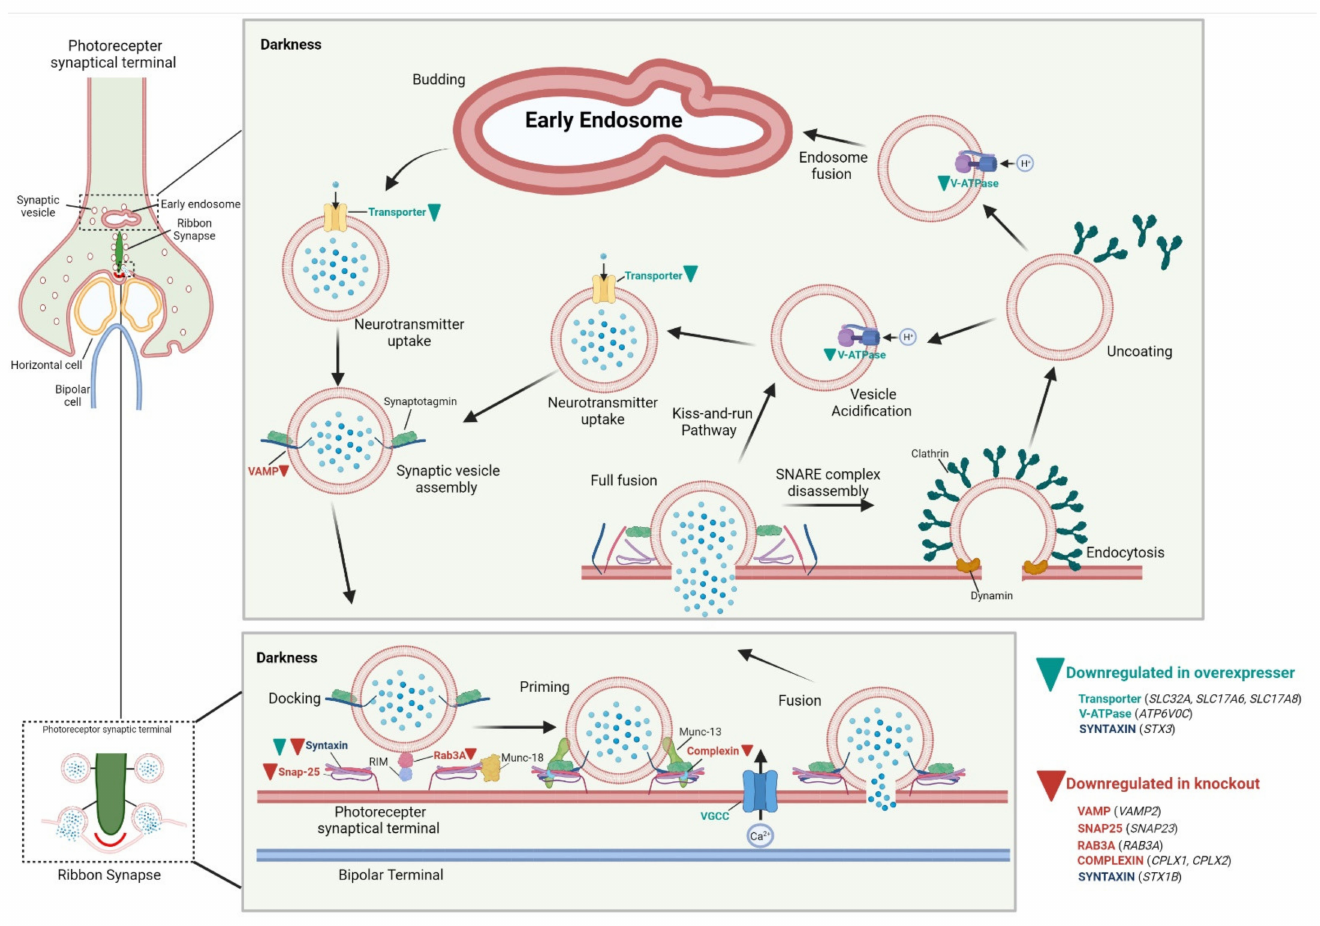
Figure 7. Downregulated genes of SOD3 mutants are associated with synaptic dysregulation. GO pathway analysis enriched for the Synaptic Vesicle Cycle pathway in both the downregulated gene lists of over-expresser and knockout animals. Genes downregulated the over-expresser are denoted in green along with a green arrowhead, while those downregulated in the knockout are in red with a red arrowhead. The gene downregulated in both is designated in dark blue with both red and green